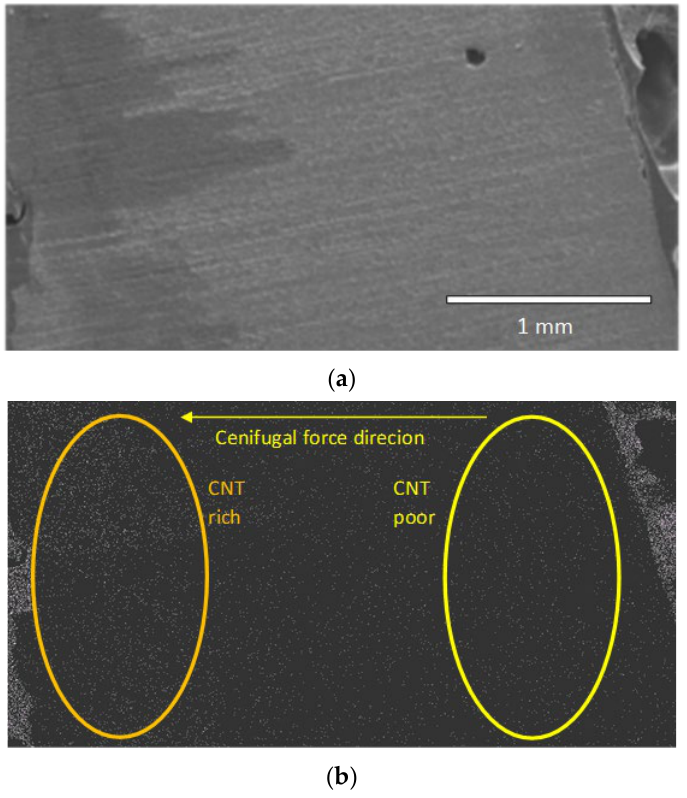
Figure 6. SEM and EDX results for FGMs with the rotating speed of 150 rpm. ( a ) SEM image and ( b ) EDX results. Table 2. Mass fraction (%) of Al and CNT in samples of FGMs with different rotation speeds.